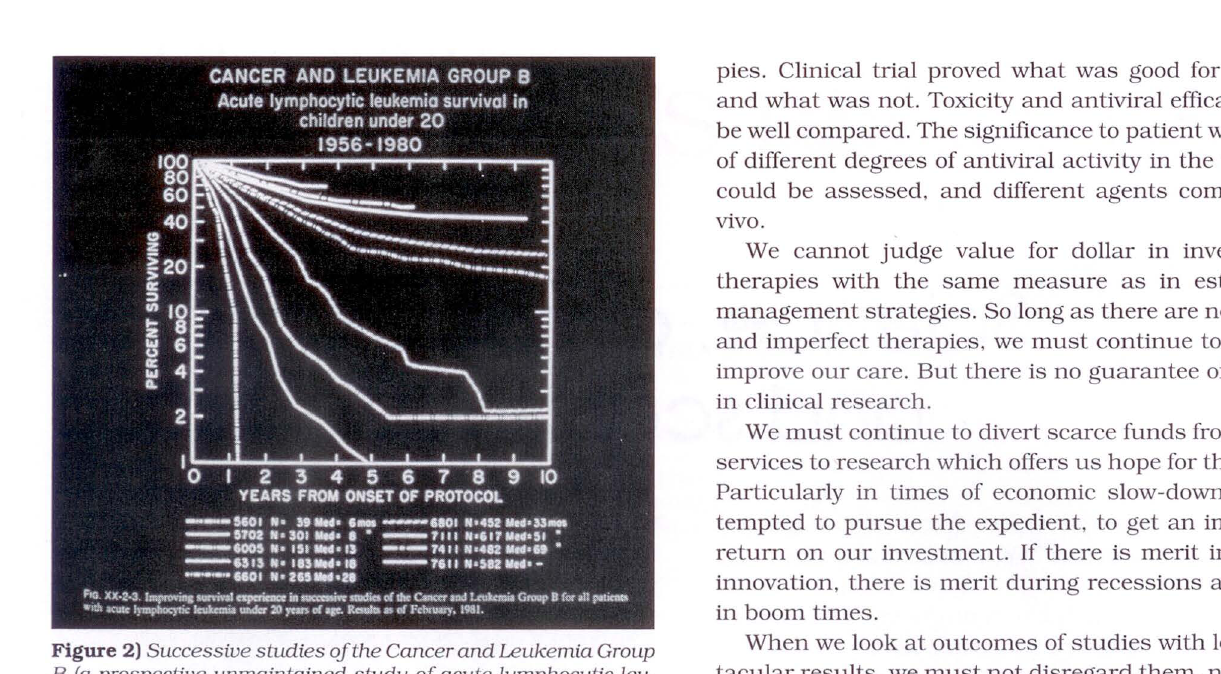
Figure 2) Successive studies of the Cancer and Leukemia Group B (a prospective unmaintained study of acute lymphocytic leu kemia comparing three regimens of methotrexate: three courses, eight months of courses, and eight months of courses plus vincristine and prednisone) for aU patients with acute leukemia under 20 years of